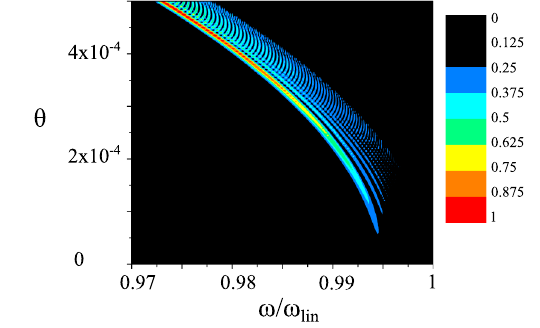
FIG. 3. (ordinate) for (cid:1) ¼ 300 and a 0 ¼ 0 : 125 , w 0 ¼ 27 (cid:10) m .